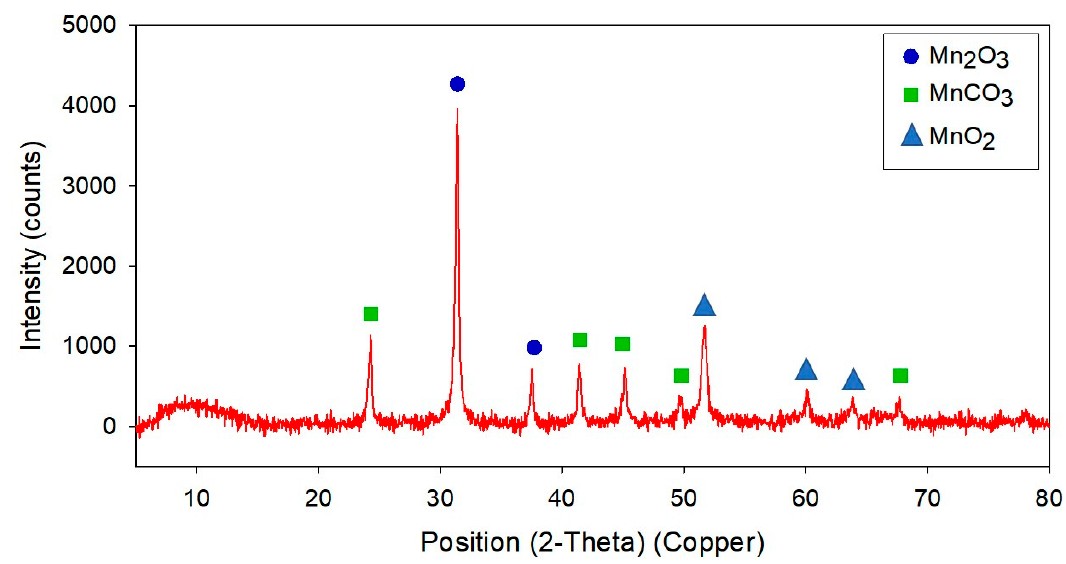
Figure 5. XRD pattern of Mn precipitates harvested from strain NDMn-6 culture.